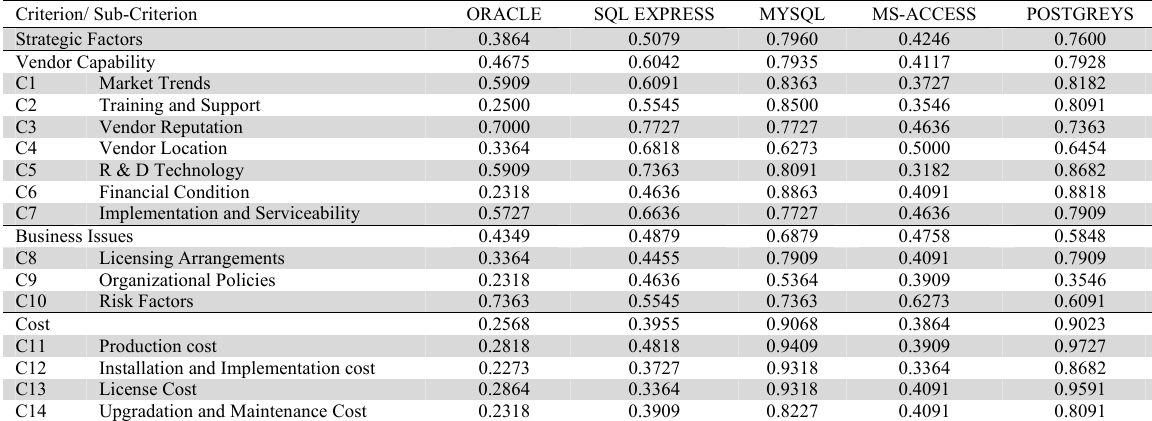
Crisp values of DBMS COTS components Criterion/